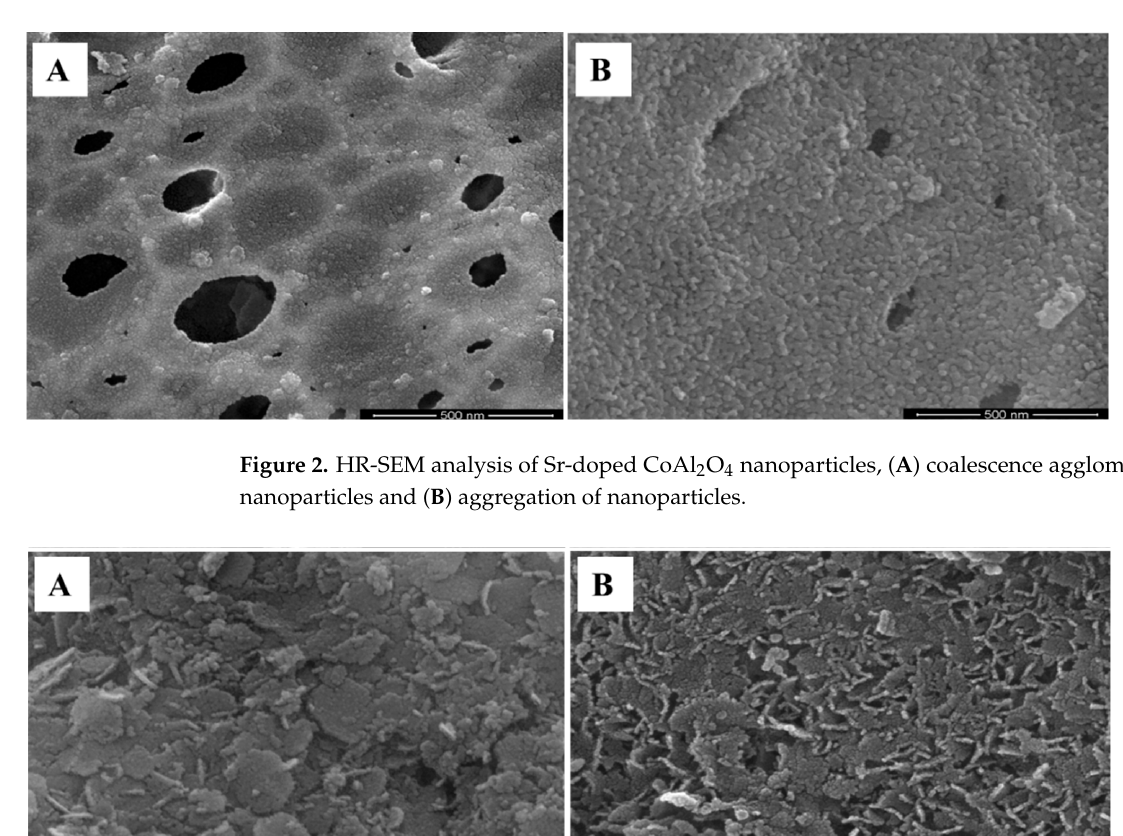
Figure 1. XRD mapping of Sr-doped CoAl 2 O 4 nanoparticles.